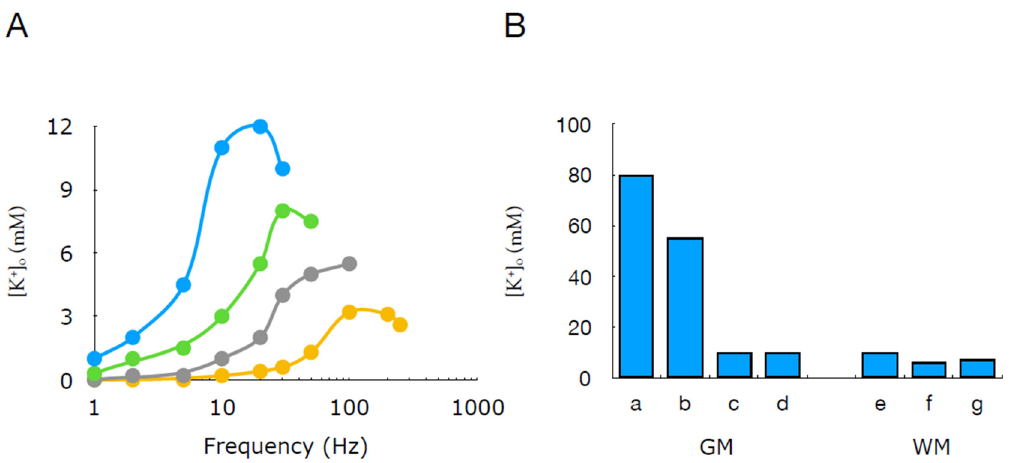
Figure 6. Elevations in [K + ] o in grey and white matter. ( A ) In rat optic nerve, the frequency dependent elevations in [K + ] o are age-dependent, with the largest increases occurring in the youngest rats (blue = 2 days, green = 6 days, grey = 13 days, orange = adult). ( B ) Increases in [K + ] o in grey (GM; a–d) or white matter (WM; e–g) associated with a = anoxia, b = spreading depression, c = seizure, d = 100 stimulus, e = anoxia, f = aglycaemia or g = 100 Hz stimulus (adapted from Ref. [96]).